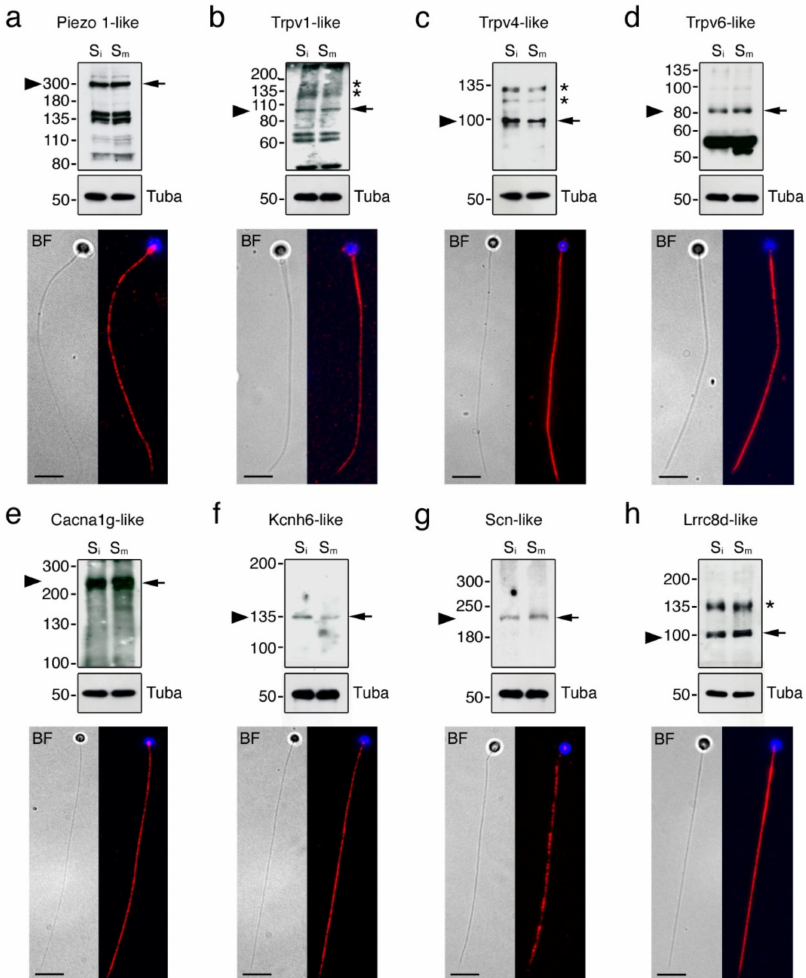
Figure 6. Confirmation of protein expression of different ion channels in seabream immotile and activated spermatozoa. ( a – h , upper panels) Immunoblots of selected ion channels in immotile and motile spermatozoa (S i and S m , respectively). Alpha-tubulin (Tuba) was used as a marker for even loading. Arrows indicate channel monomers and arrowheads the expected size of the target bands based on in silico determination of molecular masses. Asterisks indicate potential post translational modifications. Molecular mass markers (kDa) are on the left. Uncropped immunoblots are shown in Supplementary Figure S3. ( a – h , lower panels) Representative bright field (BF) images ( left ) and immunodetection ( right ; red color) of ion channels in ejaculated immotile spermatozoa. The spermatozoon nucleus is counterstained with DAPI (blue). Scale bars, 5 µ